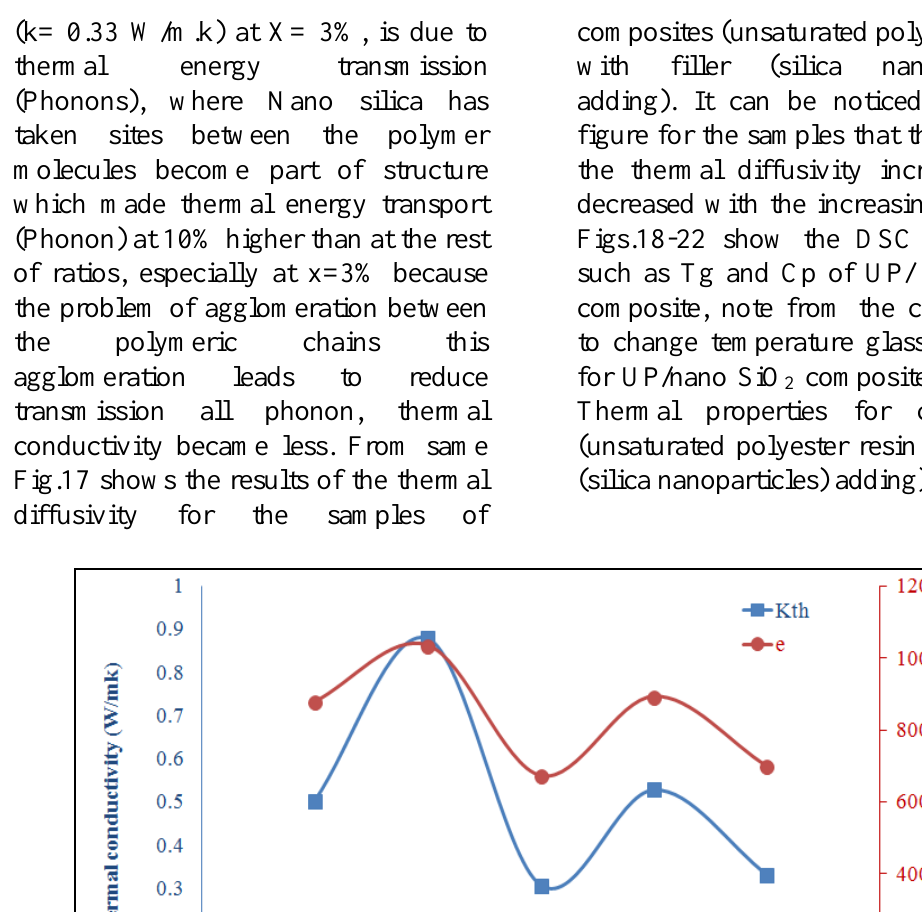
composite with ratios of added fillers. 2